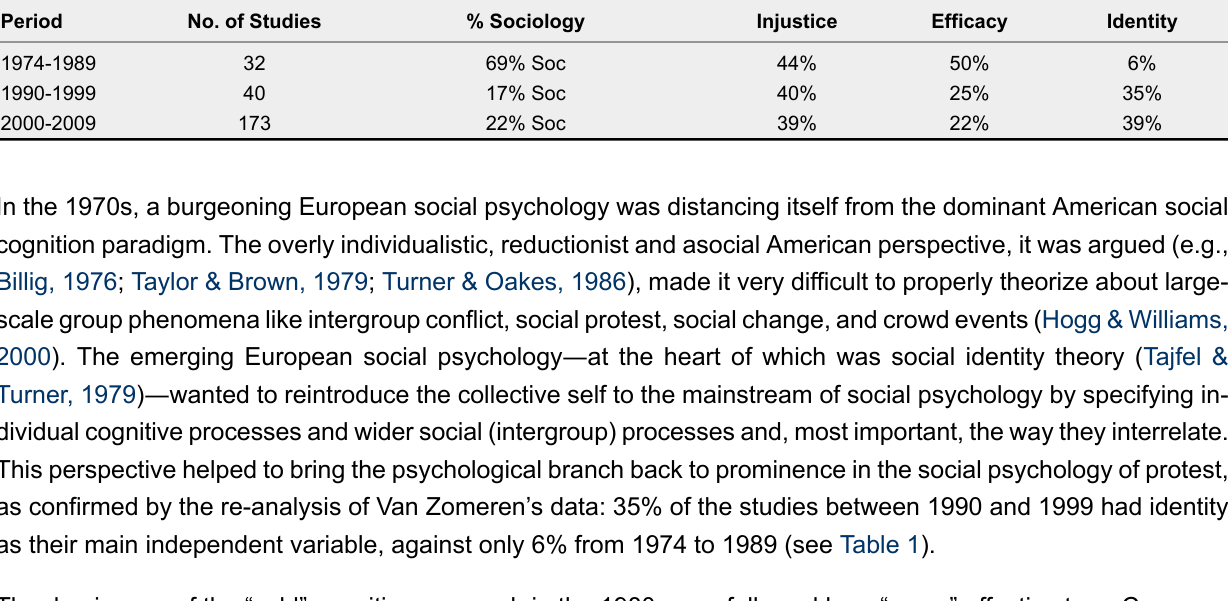
Most important IVDiscipline: Sociology vs Social Psych